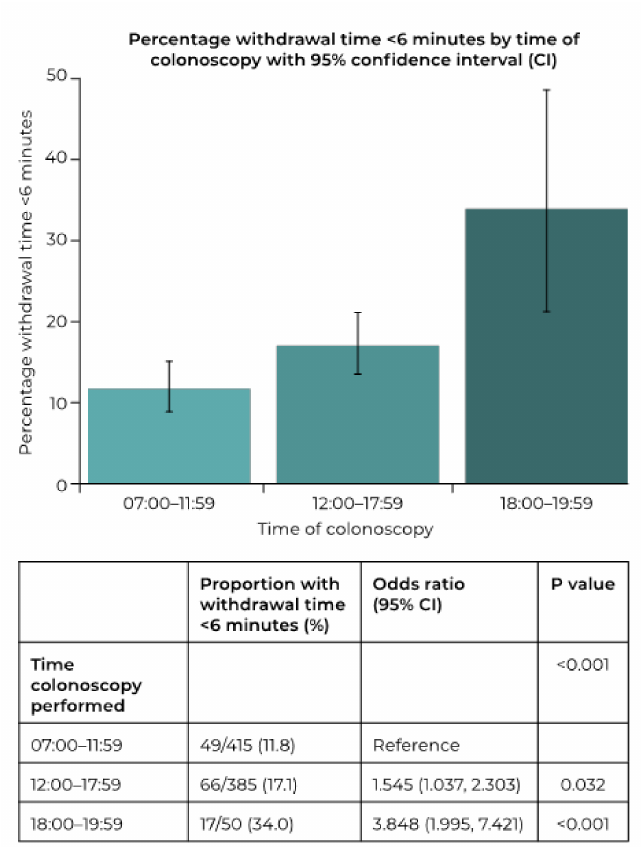
Figure 2. Influence of the time of day that a procedure is performed upon the proportion of procedures with a withdrawal time under 6 min.